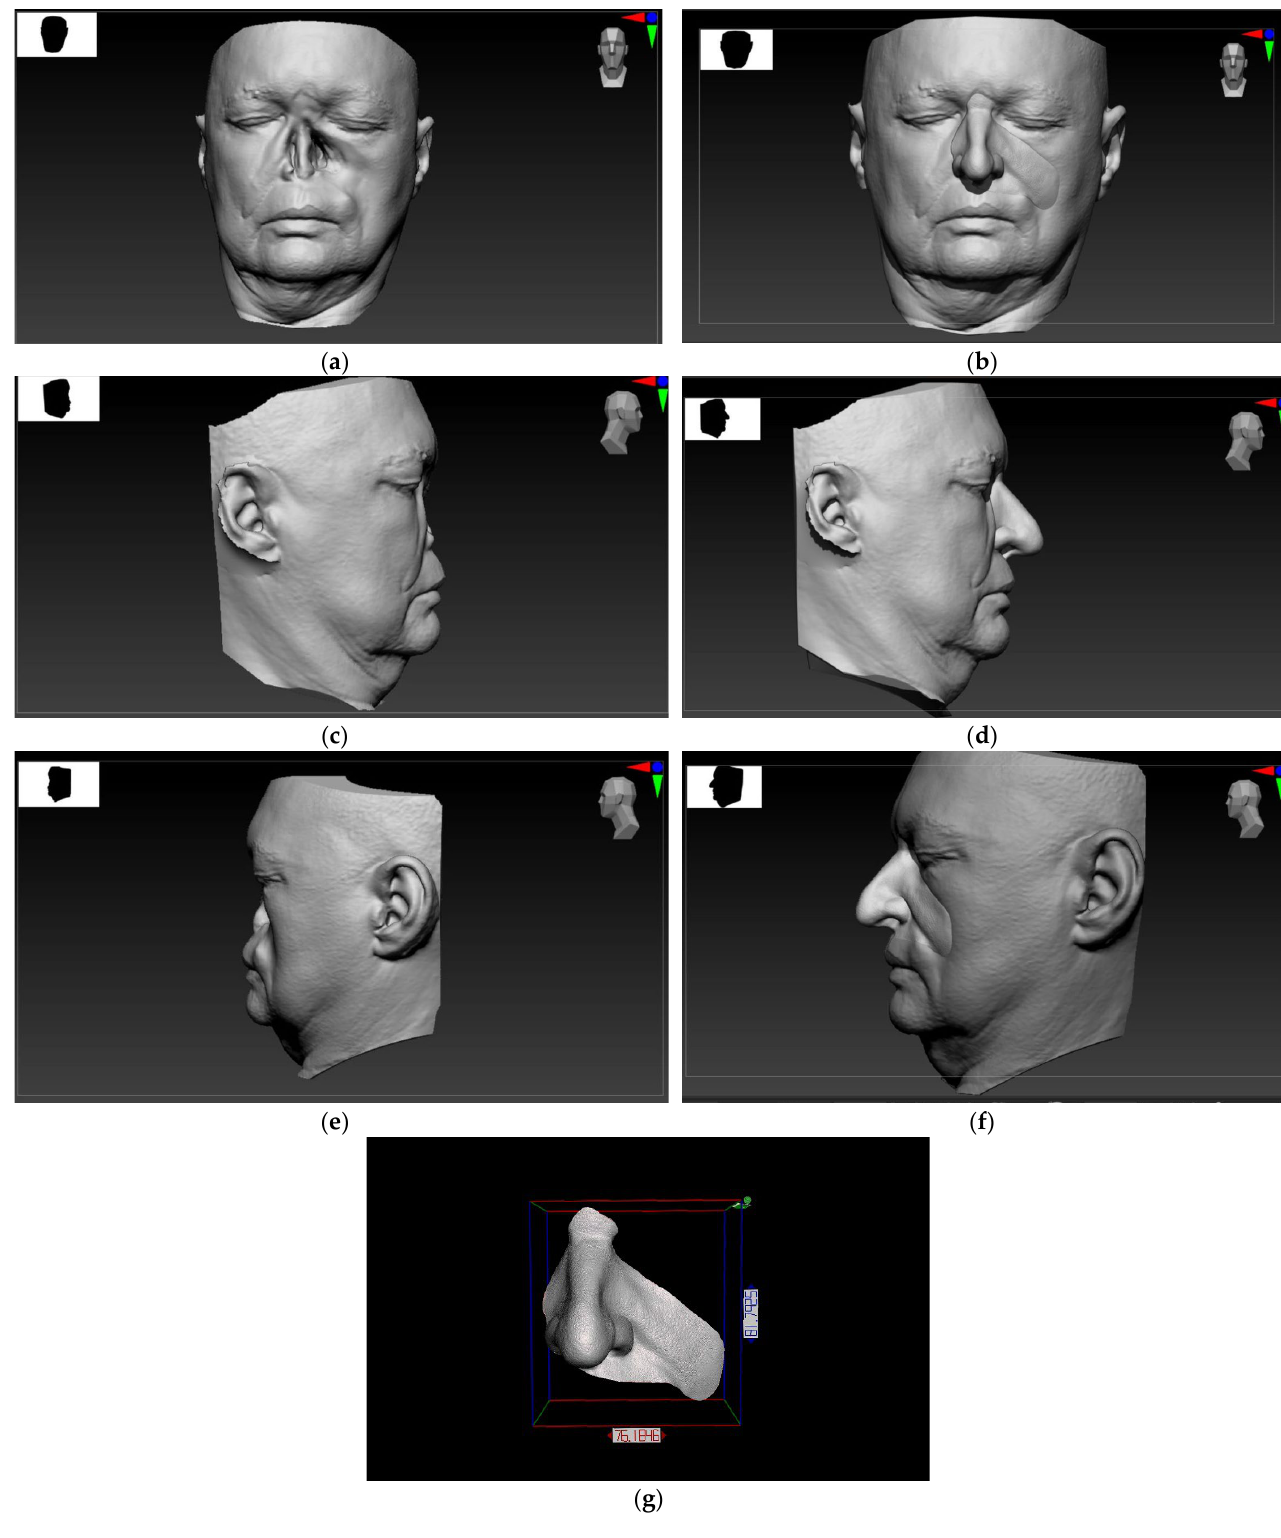
Figure 1. Digital scans of the facial topography displayed on the Zbrush software designed for digital sculpting: Extensive defect of the nose, and part of the left maxilla and cheek ( a ) en face view; ( c ) right profile view; and ( e ) left profile view of the patient. A 3D digital model design of the maxillofacial prosthesis: ( b ) en face view; ( d ) right profile view; ( f ) left profile view of the patient; and ( g ) en face view with scale